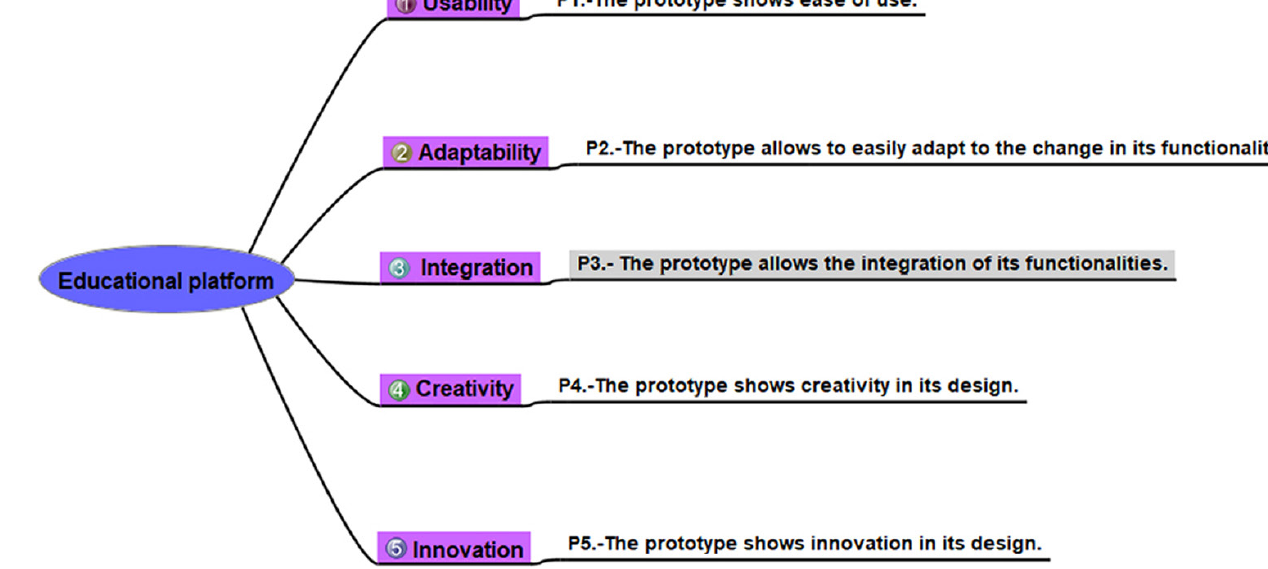
Fig. 8. Evaluation